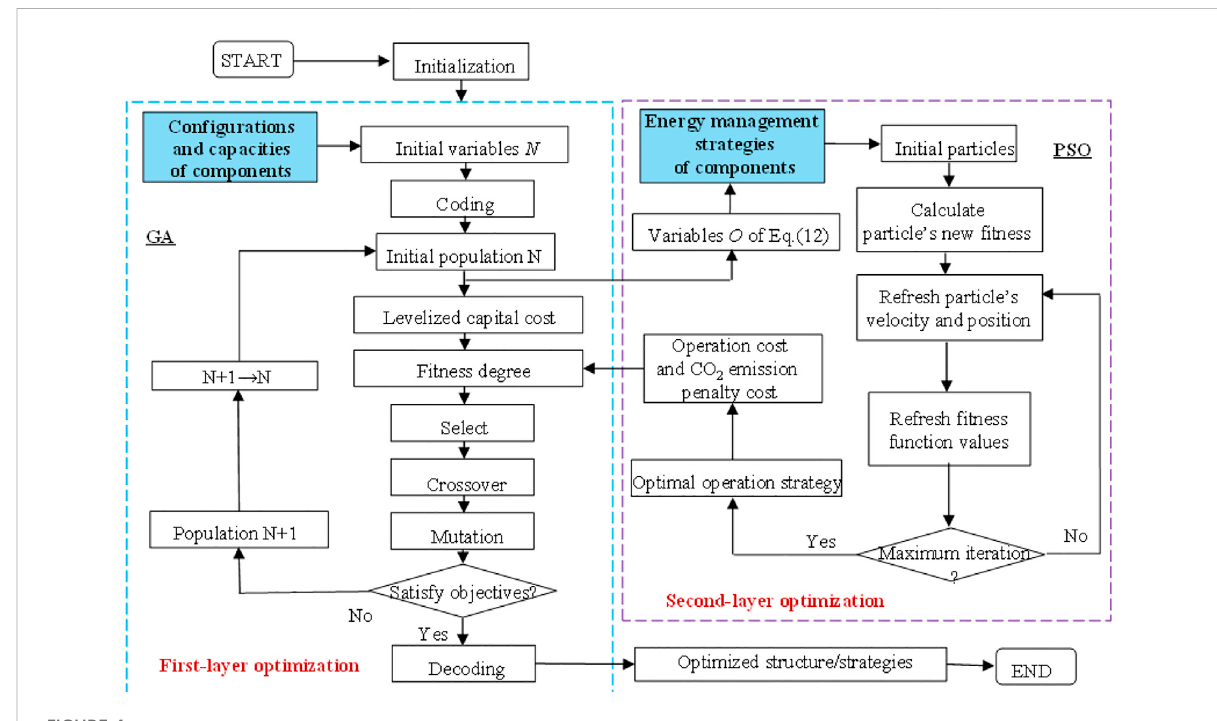
FIGURE 4 Flowchart and procedure of two-layer optimization in hybrid GA –